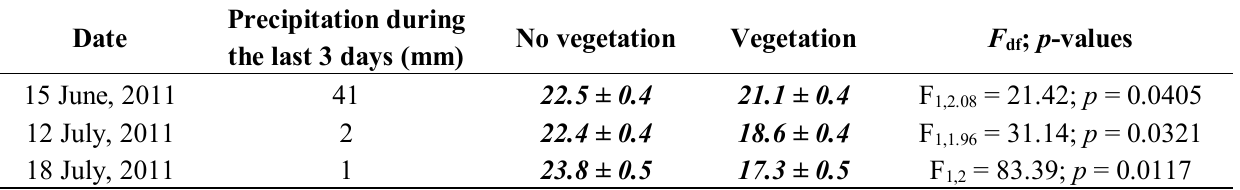
Table 4. Soil volumetric water content (%) within the first 12 cm of soil in the summer of